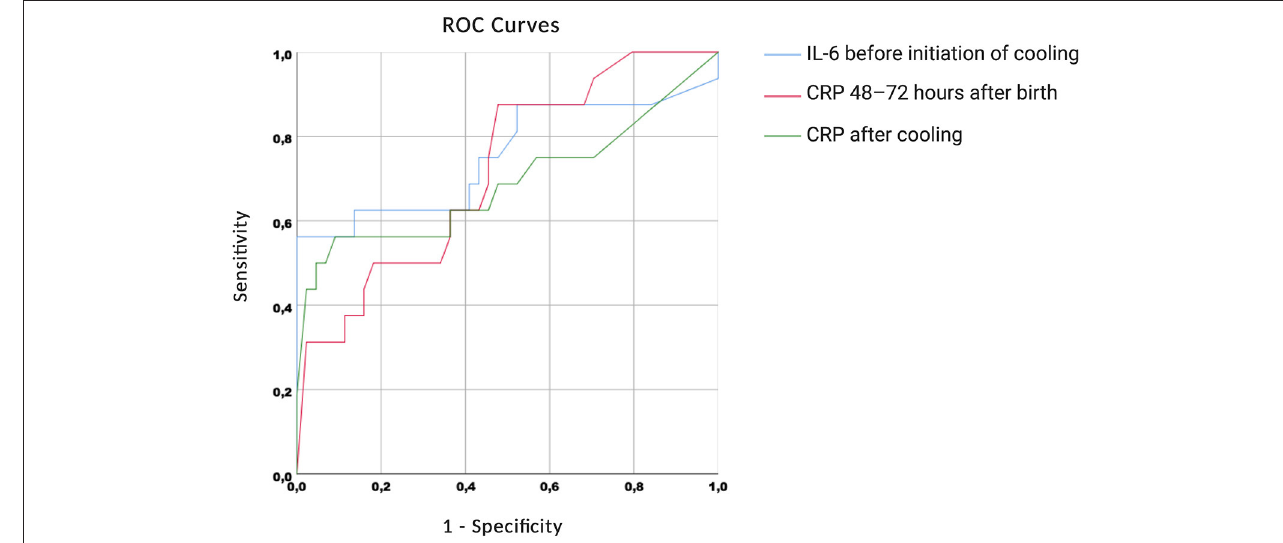
FIGURE 4 | Receiver operating characteristic curves.